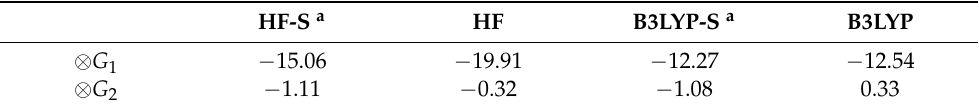
Figure 2. VX neutral hydrolysis pathway via P-S and P-O bond cleavages. Table 1. Reaction-free energies (kcal/mol) for various computational methods for the reaction pathways 1 and 2 in Figure 2.